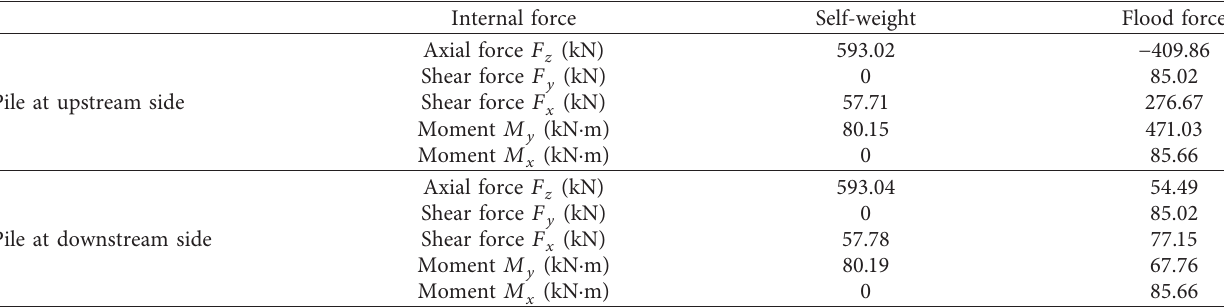
Table 8: Internal force of the